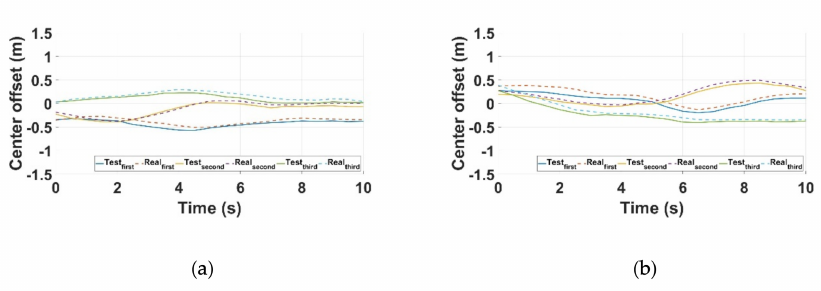
Figure 15. Comparison of theoretical values and real vehicle test results based on distance to the center of the lane: ( a ) scenario 9 and ( b ) scenario